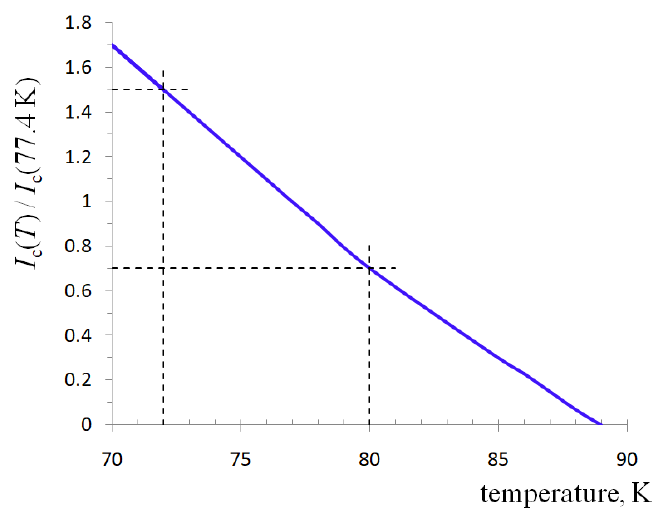
Figure 11. Multiplicity of the critical current with respect to the critical current at the temperature of 77.4 K for the SF12100 tape as a function of temperature.